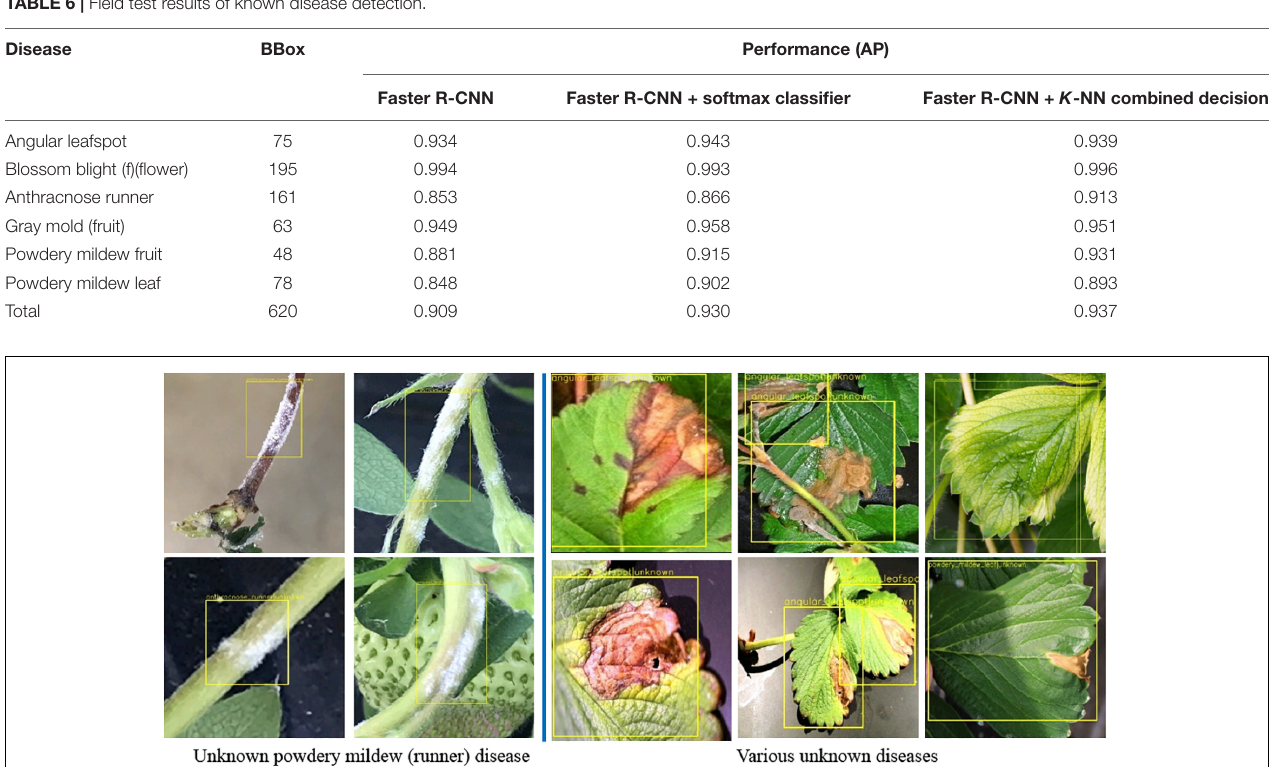
FIGURE 9 | Detected unknown